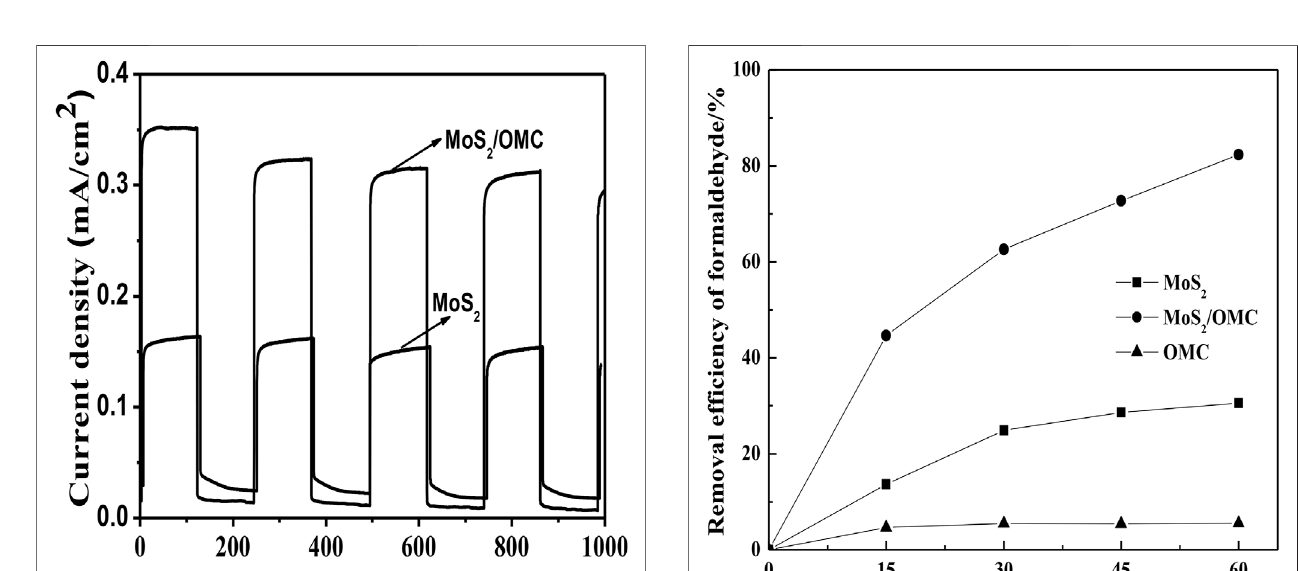
FIGURE 2 | (A) Isotherms of nitrogen adsorption and desorption and (B) BJH adsorption pore size distribution of MoS 2 /OMC.